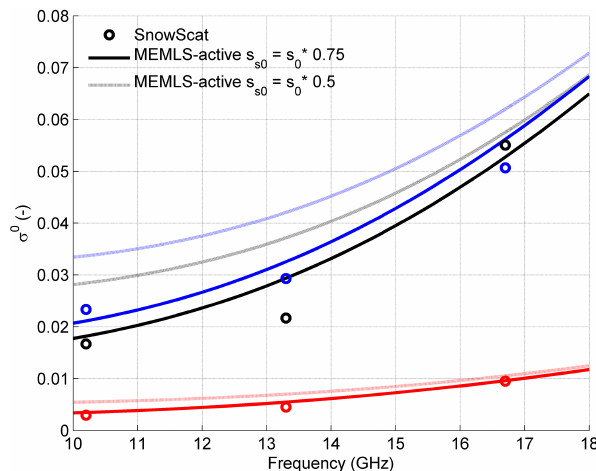
Figure 9. σ 0 at 16.7GHz measured by SnowScat (circles) and mod- eled by MEMLS3&a with CT input (lines). Colors represent polar- ization, with vv – black, hh – blue and hv – red. Best fit parameters according to Fig. 7.